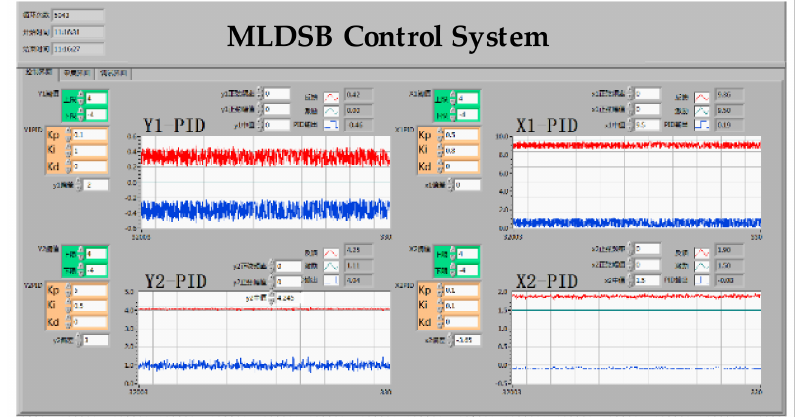
Figure 17. PC Collecting Interface of the MLDSB Testing